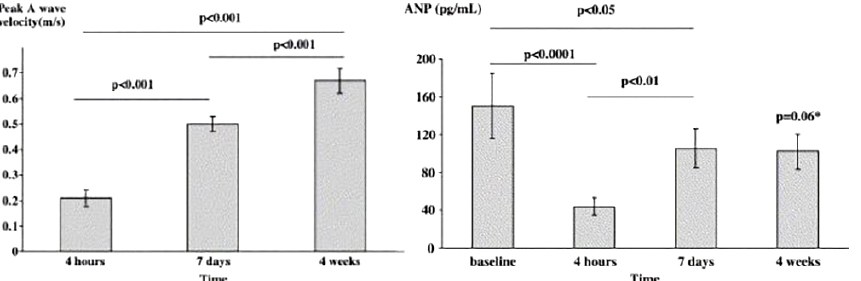
Figure 6. Mean plasma levels of ANP ( Right ) and mean peak A wave velocity ( Left ) before and after cardioversion, * p -value versus baseline